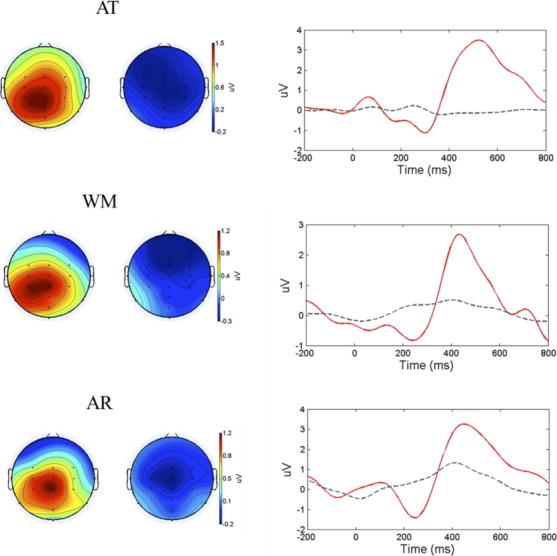
Group average scalp maps in all three tasks at 450 msec post stimulus onset. Attended (AT) and correct (WM and AR) topomaps on left side, unattended (AT) and incorrect (WM and AR) ERPs on right. ERP time courses for attended and correct (red line) versus unattended and incorrect (black line) over electrode CPz.